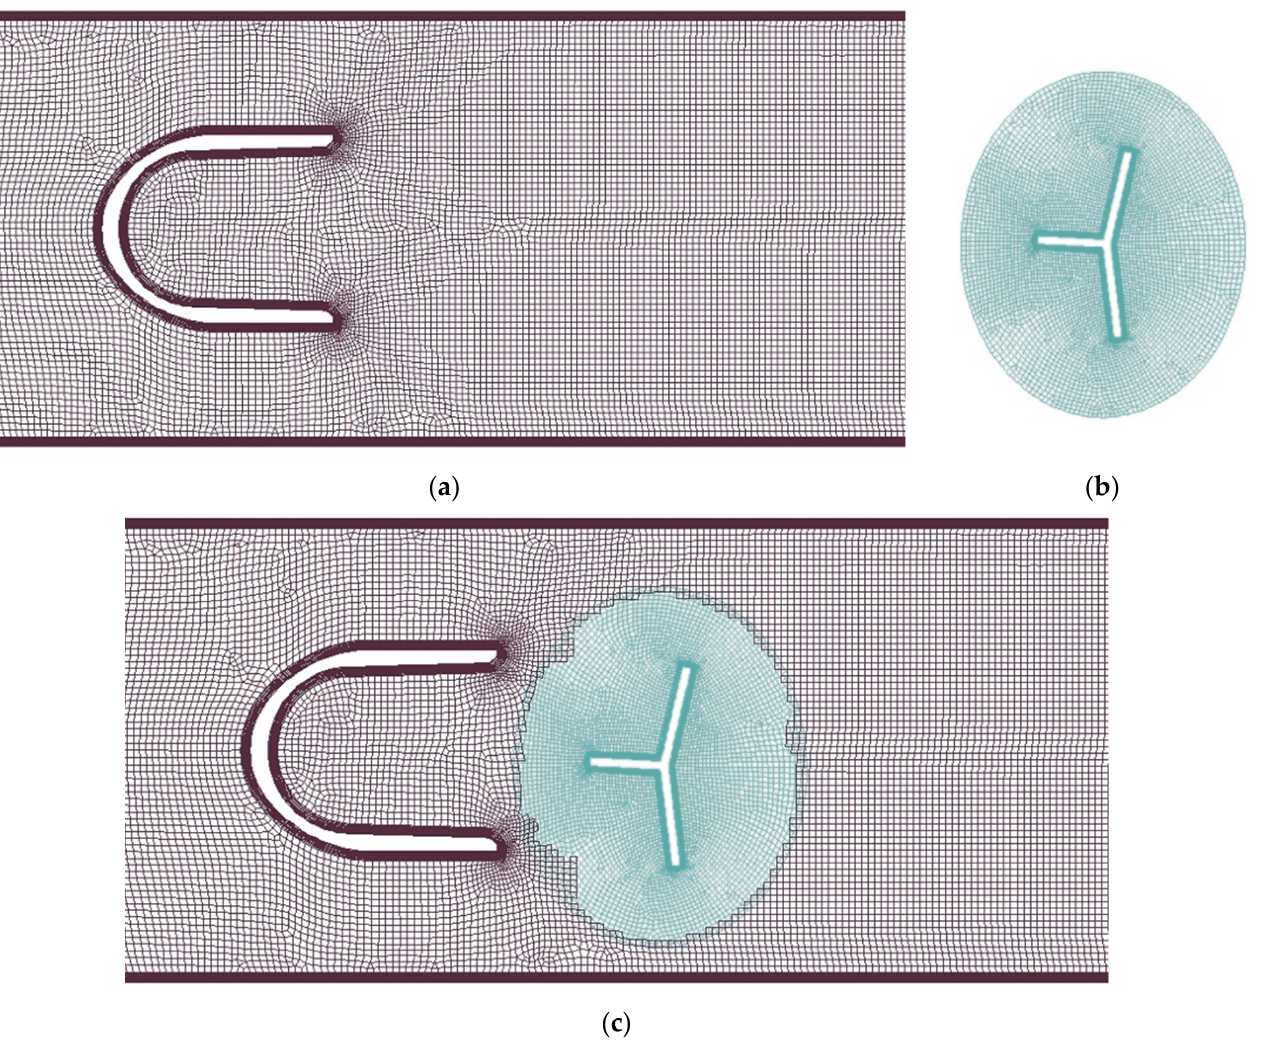
Figure 12. Two-dimensional mesh for the overset method: ( a ) background mesh; ( b ) component mesh, which moves as a rigid body with the oscillator; ( c ) superimposed grids, an overlapping interface between grids is visible.